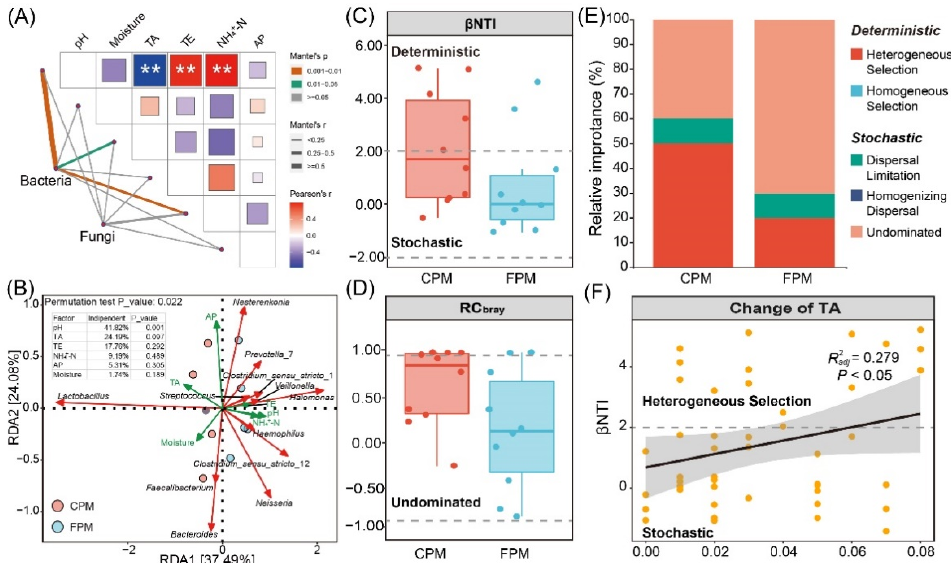
Figure 5. Determination of the driving factor for variation and assembly of bacterial community in artificial pit mud. ( A ) Mantel test of overall communities and physicochemical factors. ( B ) Redundancy analysis and hierarchical partitioning analysis of dominant bacterial genera and physicochemical factors. ( C ) β NTI results of the bacterial community. ( D ) RC bray results of the bacterial community. ( E ) Relative importance of deterministic and stochastic assembly processes in shaping bacterial community. ( F ) Linear regression analysis between β NTI and change of TA.